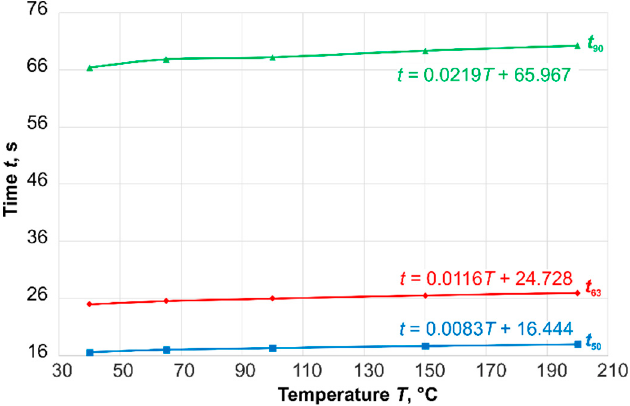
Figure 11. Experimental results (air, steps from various temperature to ambient air, v = 3 m·s − 1